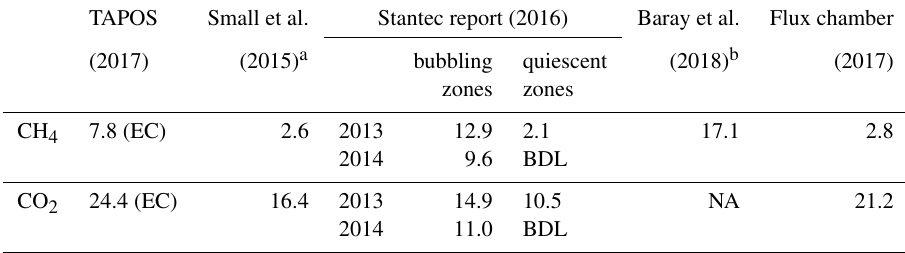
Table 2. Comparison of CH 4 fluxes (gm − 2 d − 1 ) in this study to previously reported fluxes. TAPOS Small et